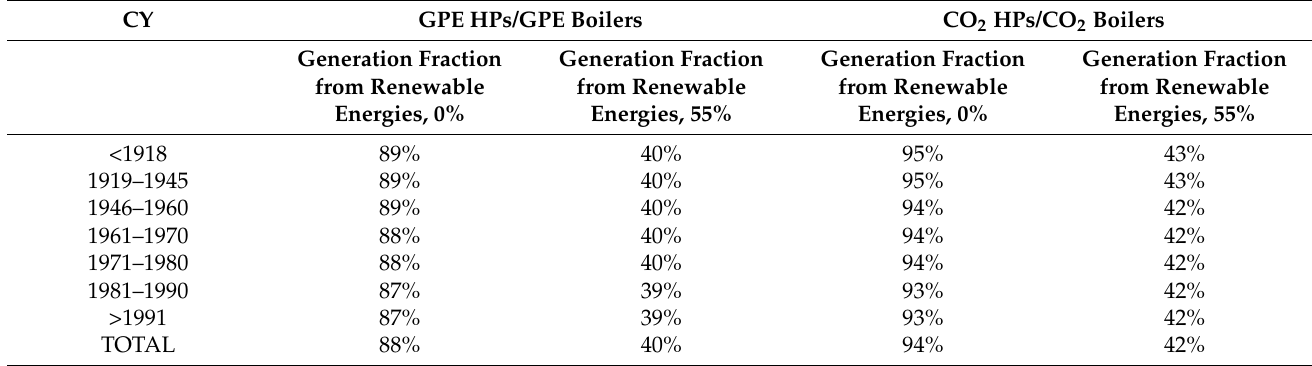
Table 10. Percentage ratio of global primary energy from fossil fuels (GPE) and CO 2 emissions of heat pumps to that of boilers per building construction year CY in the city of Salerno (generation fraction from RES 0% and 55% (2030), grid losses 10%, COP at design temperature of 2 ◦